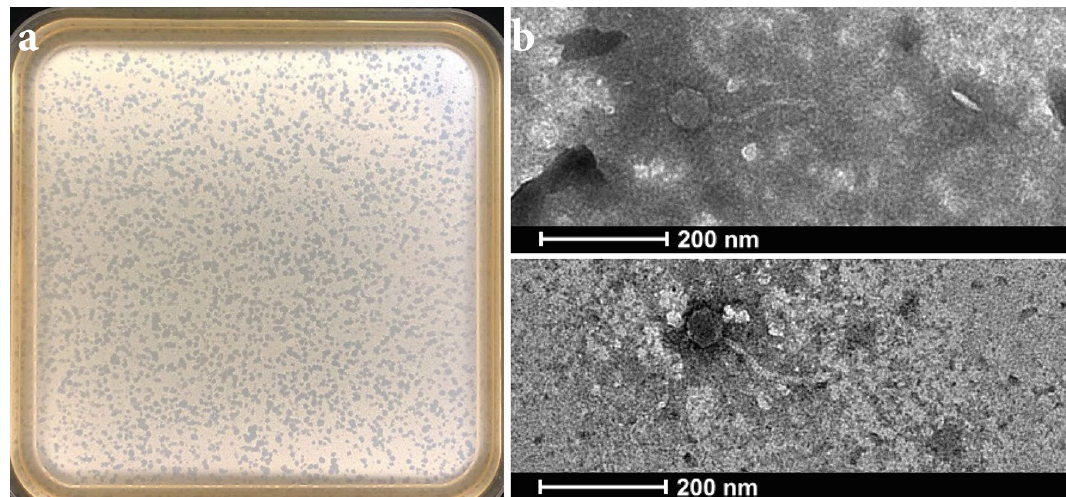
Figure 1. Morphology of phage Pablito. ( a ) Plaque morphology of phage Pablito after 24 h of infection in S. lividans using the DNB double agar overlay plate. ( b ) Representative TEM images of phage Pablito. Phage particles were stained with 2% uranyl acetate.